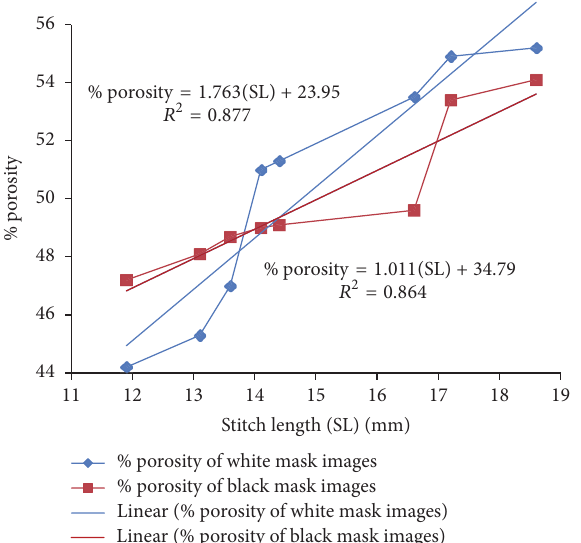
Figure 7: Percentage porosity against stitch length (SL) for single- jersey structure for FKM.